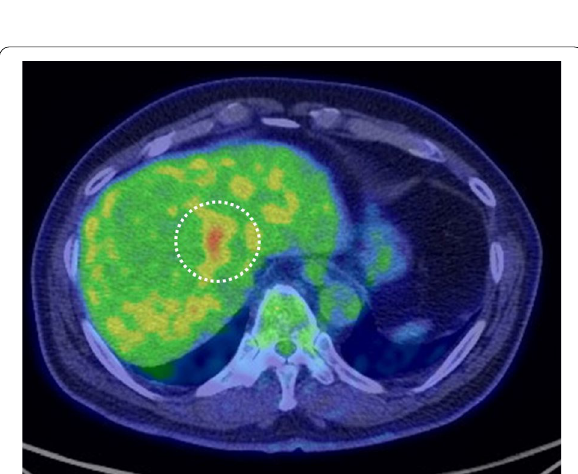
Fig. 3 Positron emission tomography-computed tomography (CT) shows an accumulation of fluorodeoxyglucose (standardized uptake value max 5.3) Fig. 4 Macroscopic examination shows that the tumor was well-defined, grayish-white, and solid, measuring